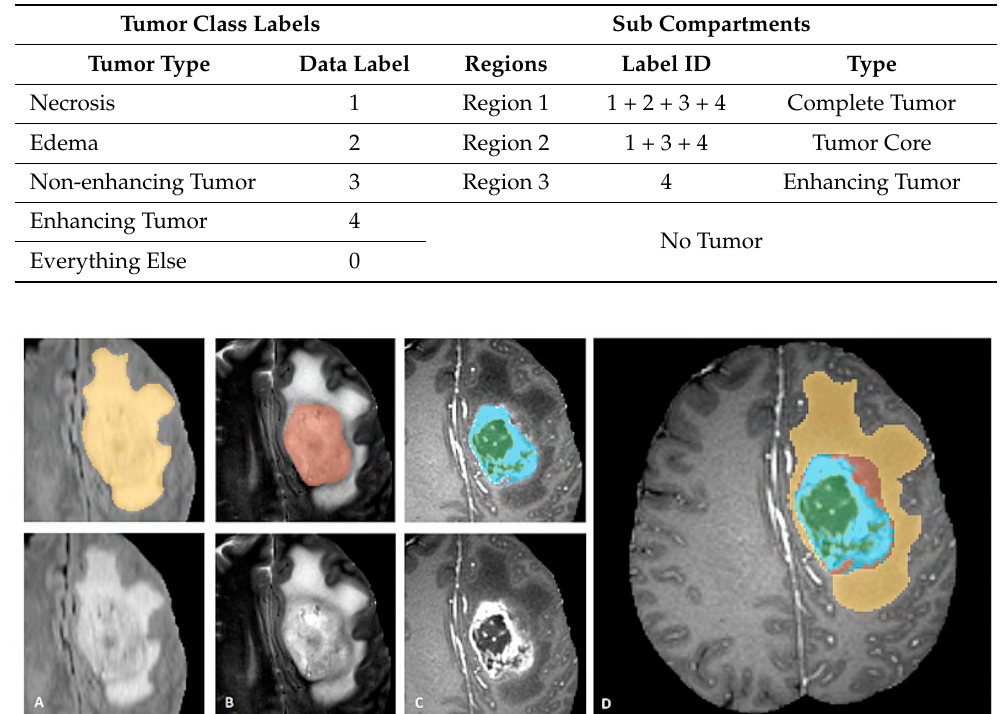
Table 3. BraTS Annotations and Sub Compartments.